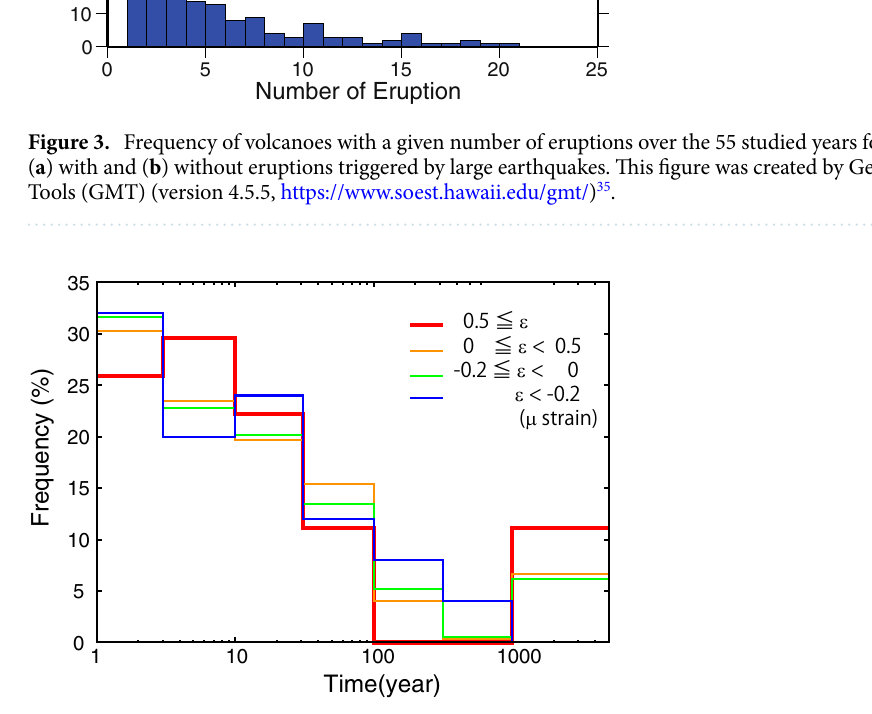
Figure 4. Normalized distributions of lag time from most recent eruption to occurrence of large earthquakes at volcanoes under different static